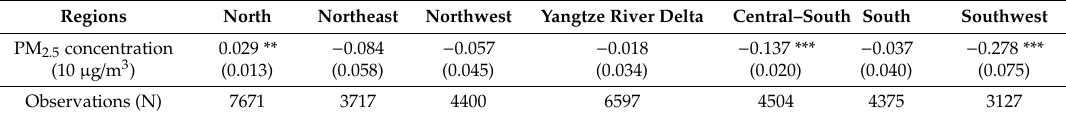
Table 5. The impact of smog on second birth intentions of the floating population in seven regions of China. Regions North Northeast Northwest Yangtze River Delta Central–South South Southwest PM 2.5 concentration (10 µ g / m 3 ) Observations (N)